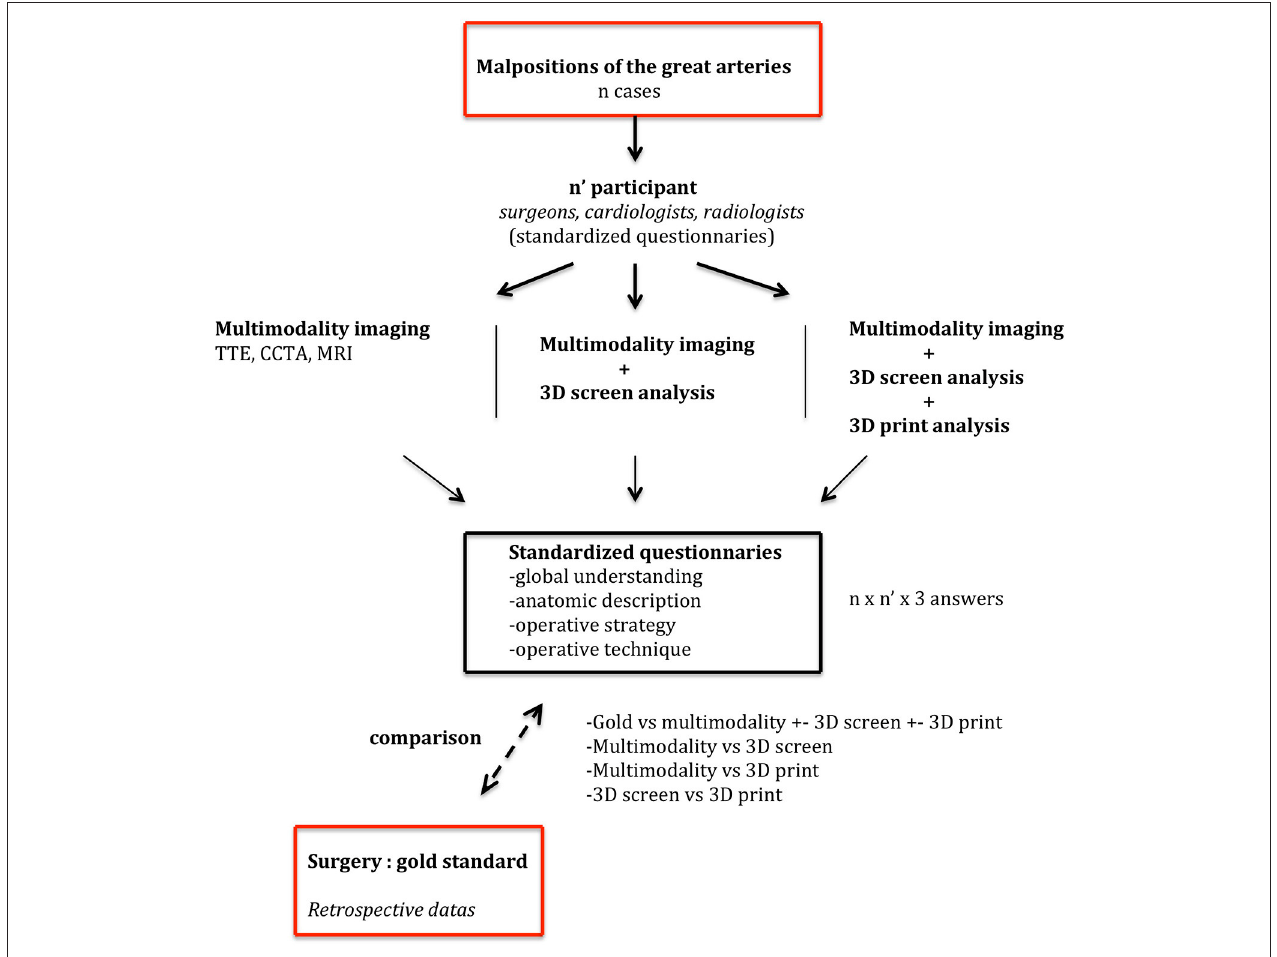
FIGURE 1 | Design proposal for a retrospective